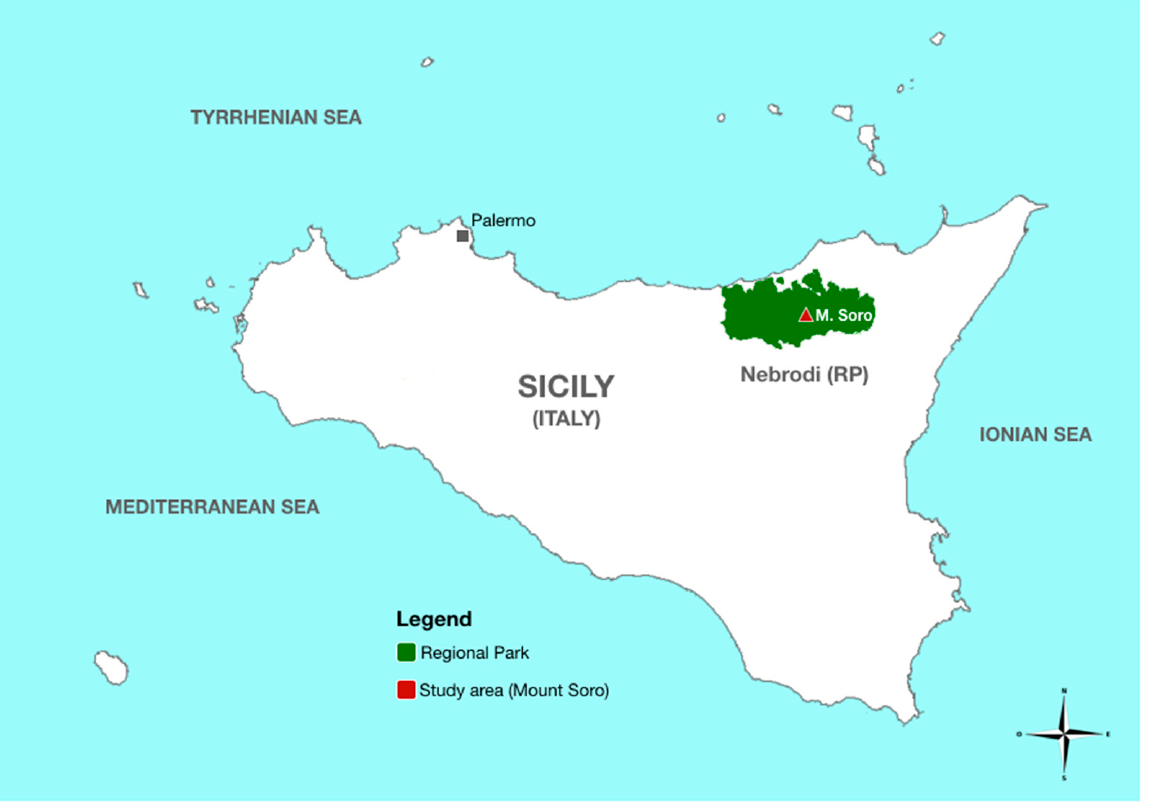
Figure 1. Geophysical map of Sicily with detail of the study area.